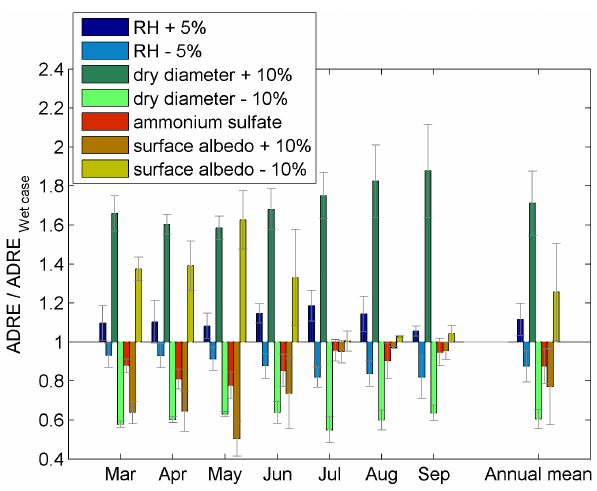
Figure 13. The sensitivity of the ratio between the calculated ADRE (new cases) and the ADRE (Wet case) to the parameters: RH, parti- cle dry size, surface albedo and aerosol chemical